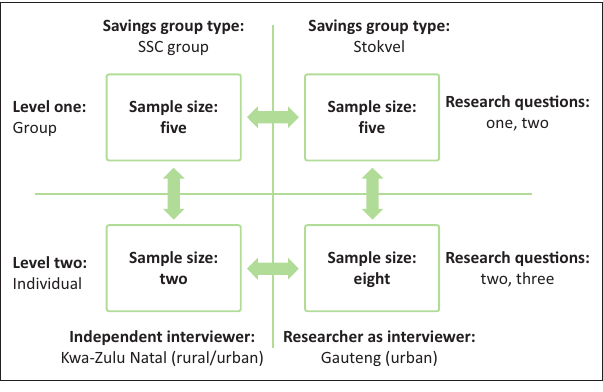
FIGURE 1: Triangulation strategy